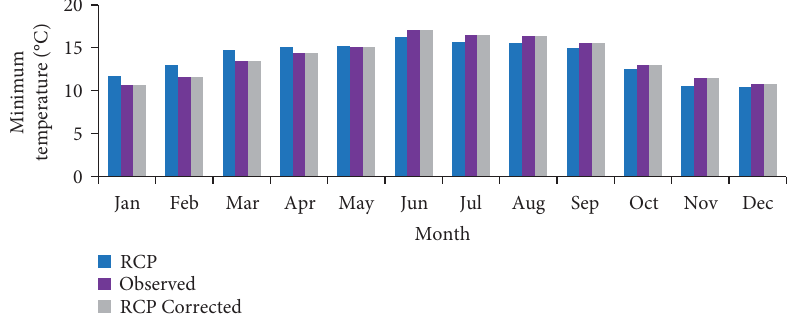
Figure 6: Bias correction of average monthly minimum temperature.